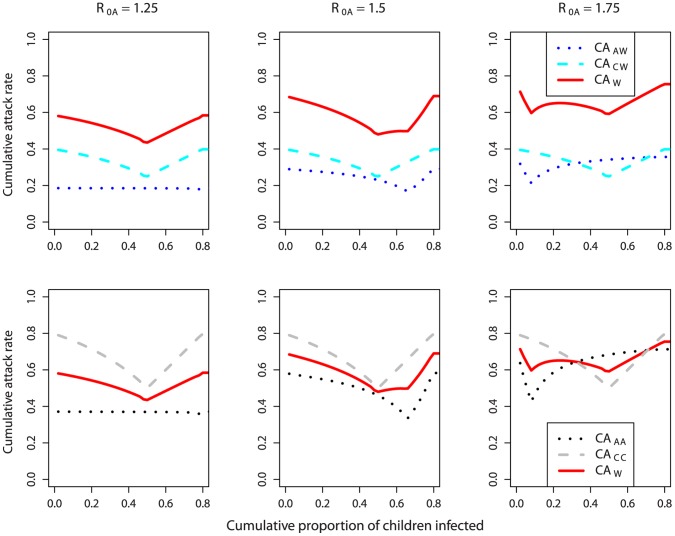
Cumulative attack rates against children’s population trigger, in the absence of inter-group transmission (βAC = βCA = 0).Values of R0A are varied: R0A = 1.25 (left); 1.5 (middle); 1.75 (right). For all panels, R0C = 2; 50% adults; 50% children. Everything else as described in Figure 5 caption.